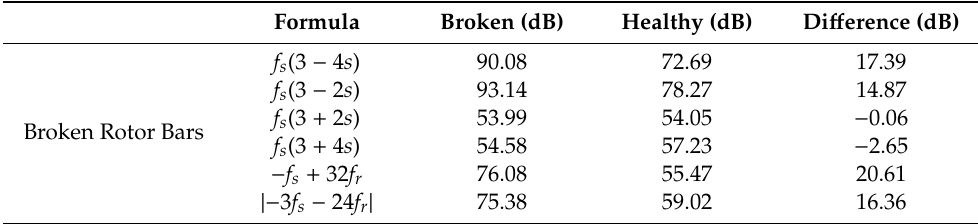
Figure 16. ZSV spectrum measured during laboratory tests for the case of a broken rotor cage bar: ( a ) window around 150 Hz, ( b ) window around 732 Hz. Table 11. Results of harmonics amplitude measurements of the characteristic frequency for a rotor cage fault, obtained from laboratory tests.